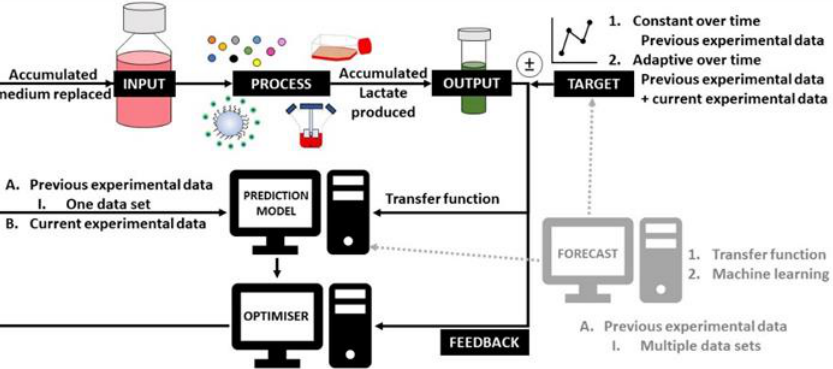
Figure 1. Different modelling techniques in the model predictive controller (MPC) of this